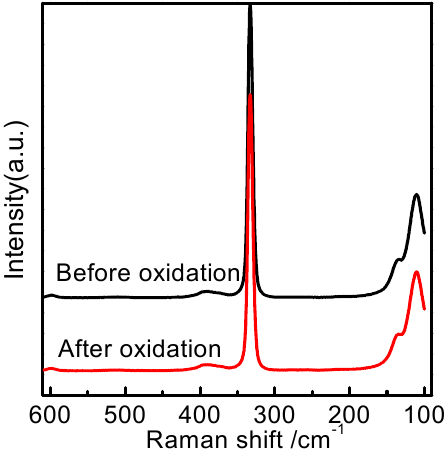
Figure 3. Raman spectra of homogeneous [bmim]Fe(III)Cl 4 –H 2 O mixtures at x (H 2 O) = 5.88% before and after oxidative-absorption of H 2 S.